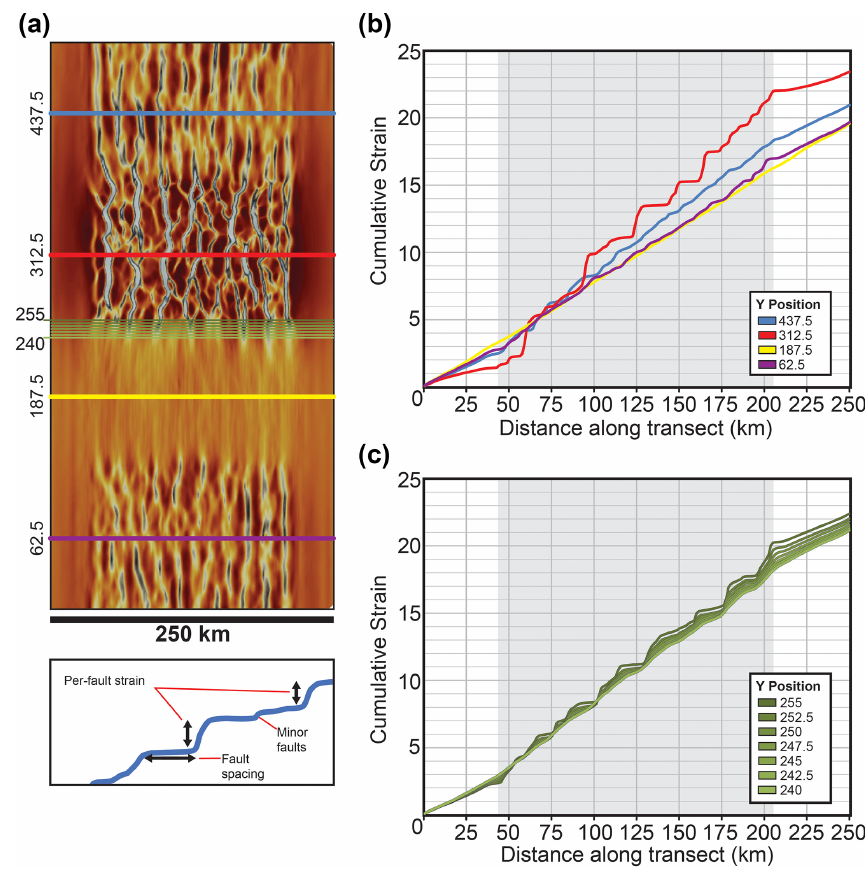
Figure 5. (a) Map view image of non-initial plastic strain at 10Myr across the central 250km of the model. (b) Strain analysis of multiple transects across the centre of each domain of the model; see (a) for the location. The grey-shaded area represents the location of the damage zone initially across the central 150km of the model. Note how fault spacing and per-fault strain are greatest in the weak domain, whilst the strong domain approximates uniform strain. (c) Strain analysis of a series of model transects spanning the boundary between the strong and weak domains. Fault spacing and per-fault strain decrease across the boundary into the strong